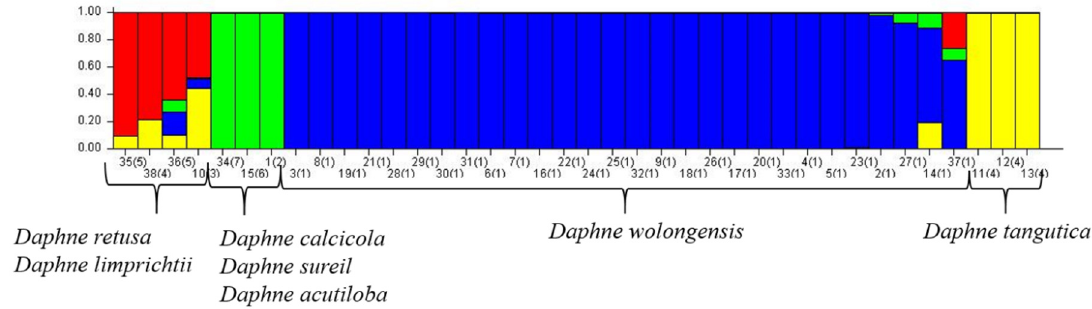
Figure 3. Dendrogram constructed using an unweighted neighbor joining clustering method based on a genetic distance matrix computed by means of Jaccard coefficients with 2000 bootstraps.